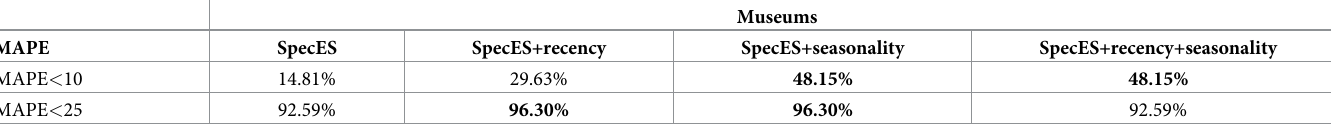
Table 6. SpecES prediction results augmented with the other two tourism requirements—seasonality and/or recency, trained for each of the 27 museums in U.K. (indoors). The best prediction models are in bold face.